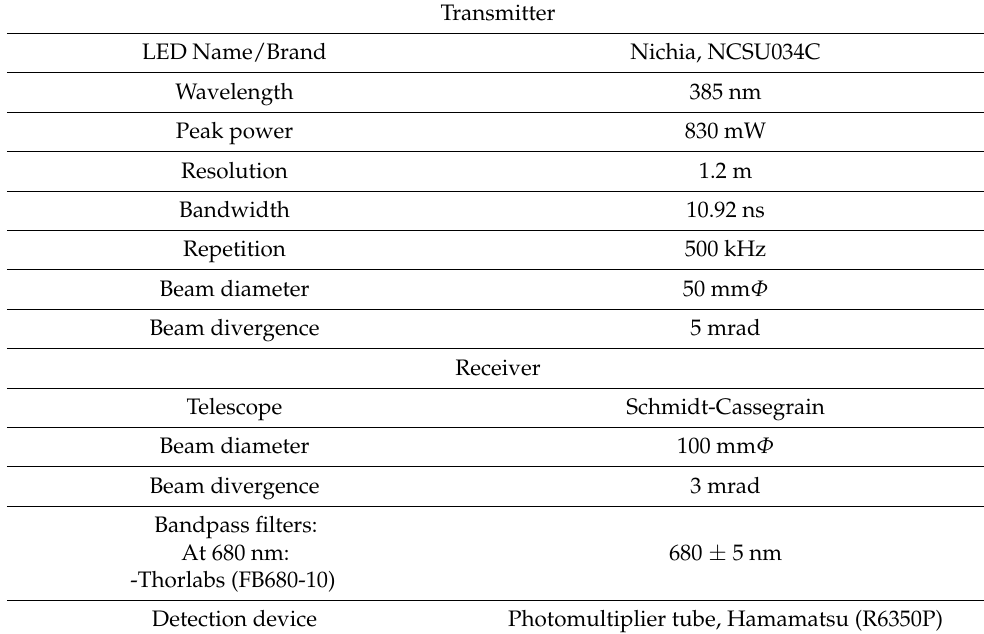
Table 2. Specifications of the pulsed LED fluorescence LiDAR system.